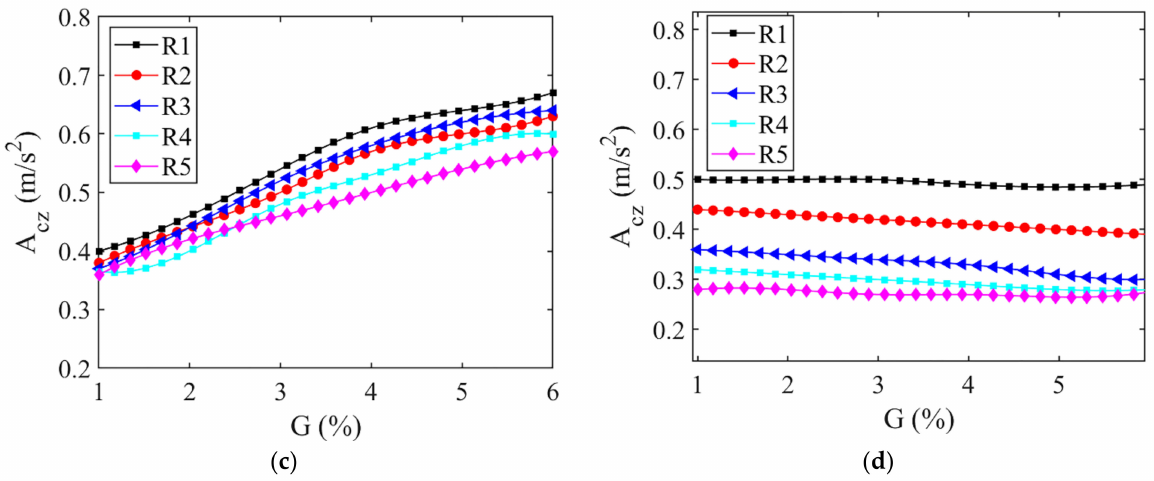
Figure 13. The dynamic characteristics evaluation indexes: ( a ) The vertical force peak curve of driving wheels; ( b ) The vertical force peak curve of guiding wheels; ( c ) The vertical acceleration of the vehicle body; ( d ) The lateral acceleration of the vehicle